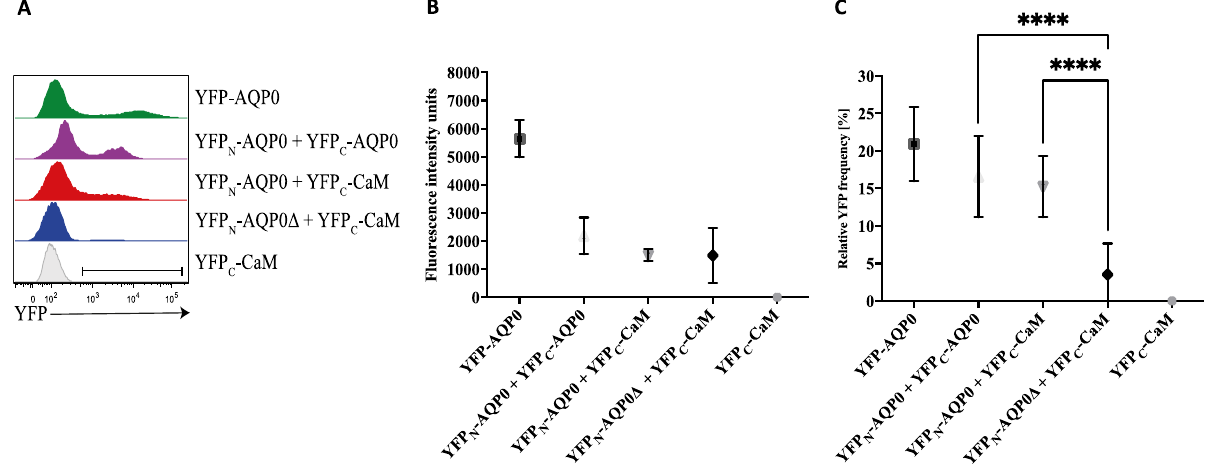
Figure 5. Quantification of BiFC yields using flow cytometry. ( A ) Analysis of constructs compared in this study together with the single plasmid negative control (YFP C − CaM). The histograms show the distribution of fluorescence intensities in the log phase of growth. The fluorescence signal was evaluated from a threshold value of 500 intensity units, discriminating the YFP-signal from auto fluorescence. ( B ) Average fluorescence intensity is shown for each complex together with the standard error of the mean (n ≥ 10 technical repeats based on at least three biological repeats, i.e. independent transformation events, see Table 1). ( C ) The average of the fraction of fluorescent cells in percentage is shown for each complex together with standard error of the mean (n ≥ 10 technical repeats based on at least three biological repeats, i.e. independent transformation events). An unpaired two component t-test with Welch’s correction was used to determine statistical difference of fluorescence frequency between YFP N − AQP0 + YFP C − CaM and YFP N − AQP0∆ + YFP C − CaM as